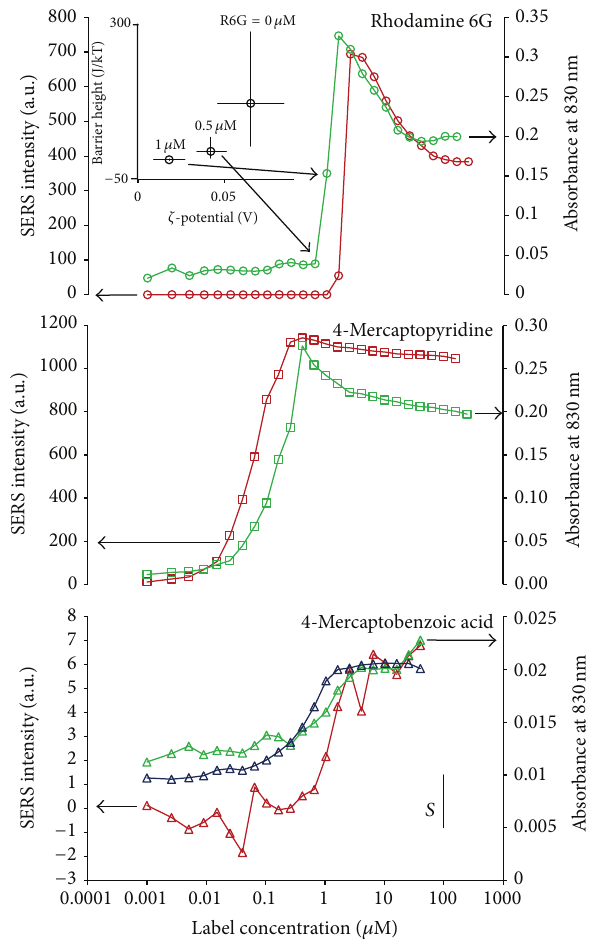
Figure 5: Variation of integrated Raman intensity (left scale, red symbols) alongside aggregate-band extinction (right scale, green symbols) as a function of SERS label titrant concentration; R6G (circles, top), MPY (squares, middle), and MBA (triangles, bottom). The bottom panel also includes the wavelength corresponding to variation in 𝜆 MAX for the localized surface plasmon (blue, triangles). The scale bar indicates a red-shift (up) of 1nm. The upper left inset shows the variation of computed DLVO barrier to particle aggregation as a function of the estimated 𝜁 -potential for three nanoparticle specimens incubated with different concentrations of R6G (0.0, 0.5, and 1 𝜇